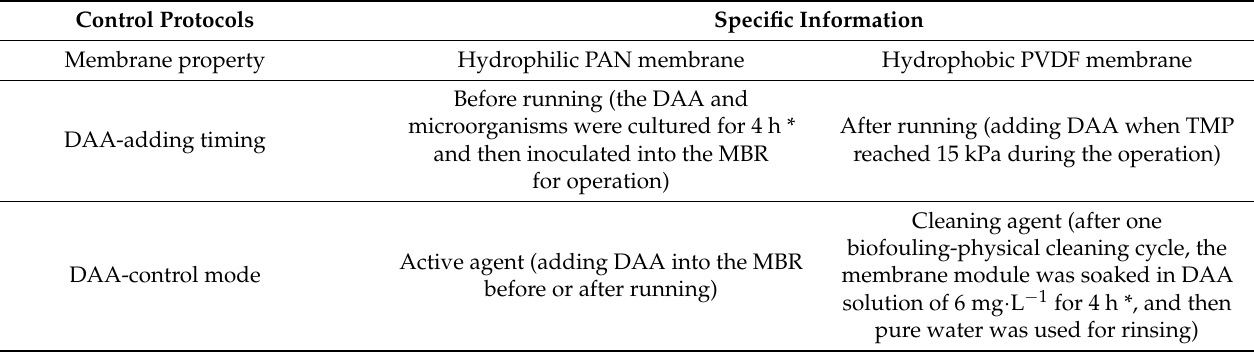
Table 2. The control protocols of DAA in